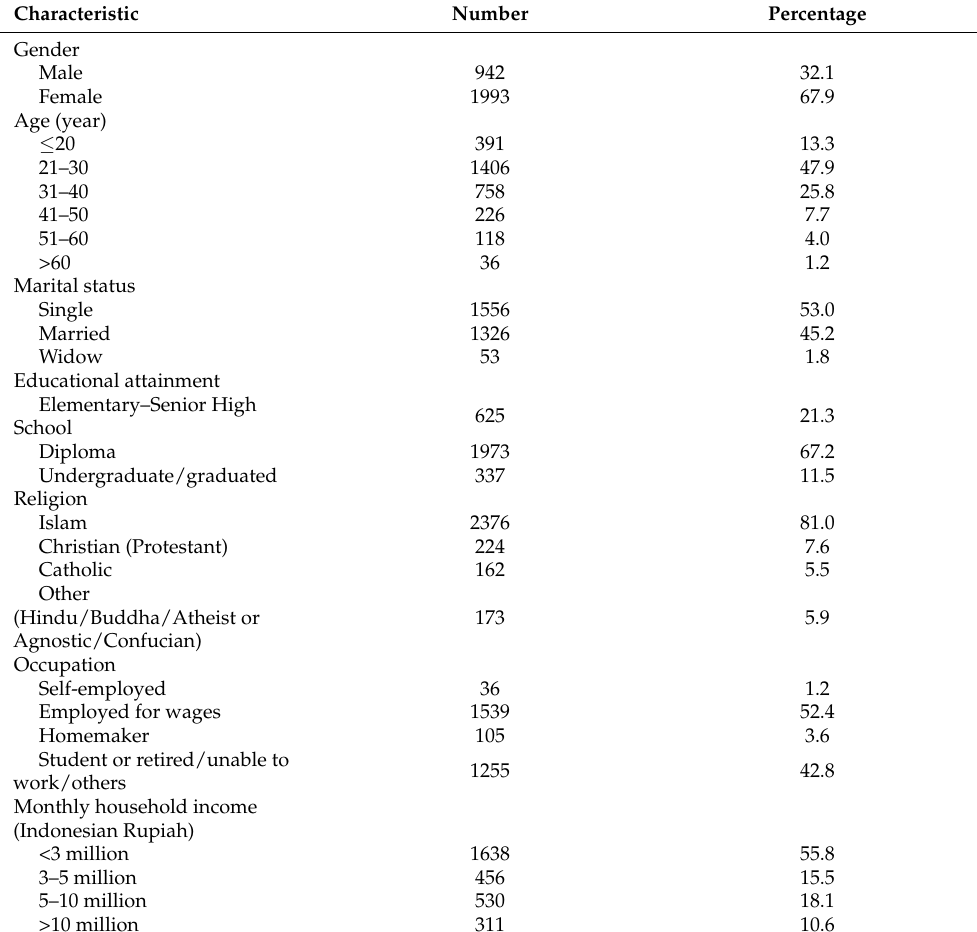
Table 1. Demographic characteristics of the respondents ( n =